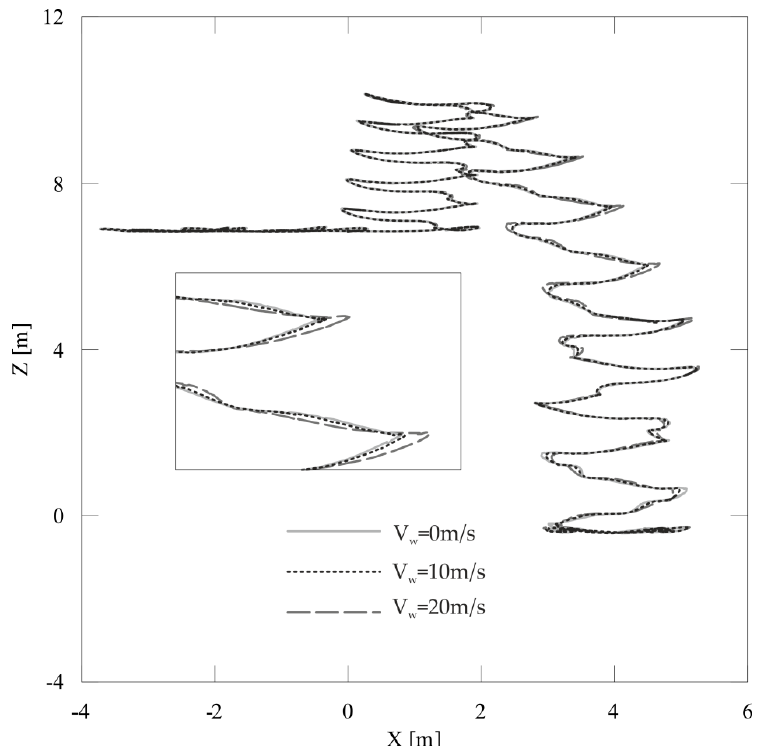
Figure 23. Trajectory projections of the carried load’s center of mass in one of the lifting planes (wind power having impact according to the direction of the Y axis).